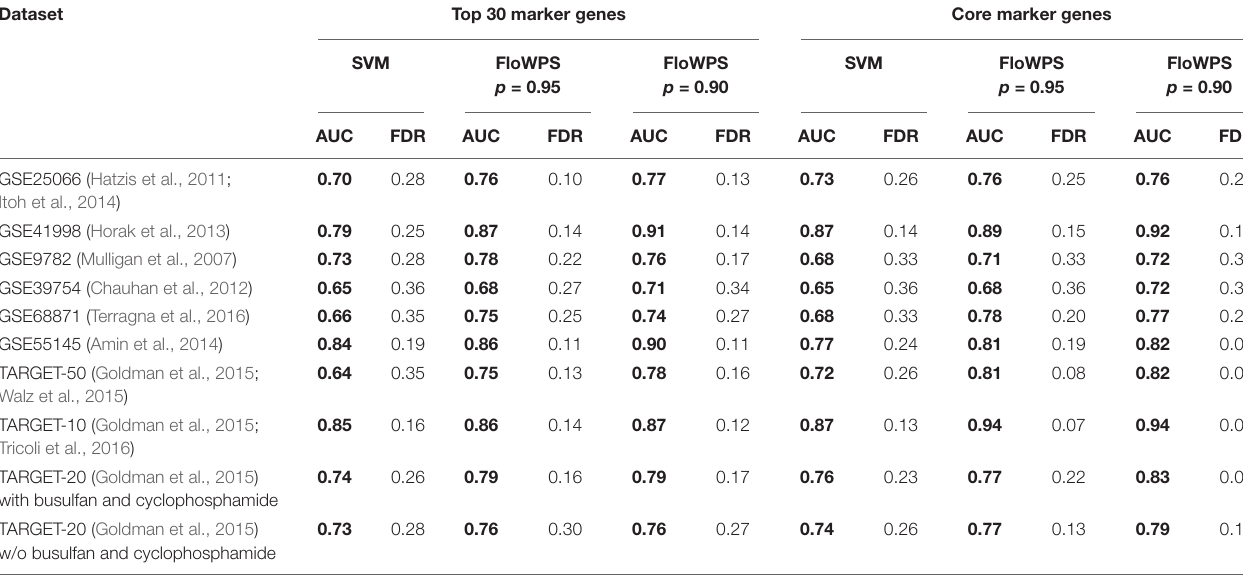
FIGURE 2 | Optimization of data trimming parameters m and k for a given individual. (A) Overall scheme for prediction for an individual sample i = 1, N . All but one individuals serve as a training dataset. For a training dataset at the fitting step, the AUC for a classifier prediction is calculated and plotted (B) as a function of data trimming parameters m and k . Positions of this AUC topogram where AUC > p · max(AUC), p = 0.95, are considered prediction-accountable (highlighted with bright yellow color) and form the prediction-accountable set S . This AUC topogram, as well as the set S , is individual for every validation point i . TABLE 2 | Performance of clinical response classifiers for clinically annotated gene expression datasets.